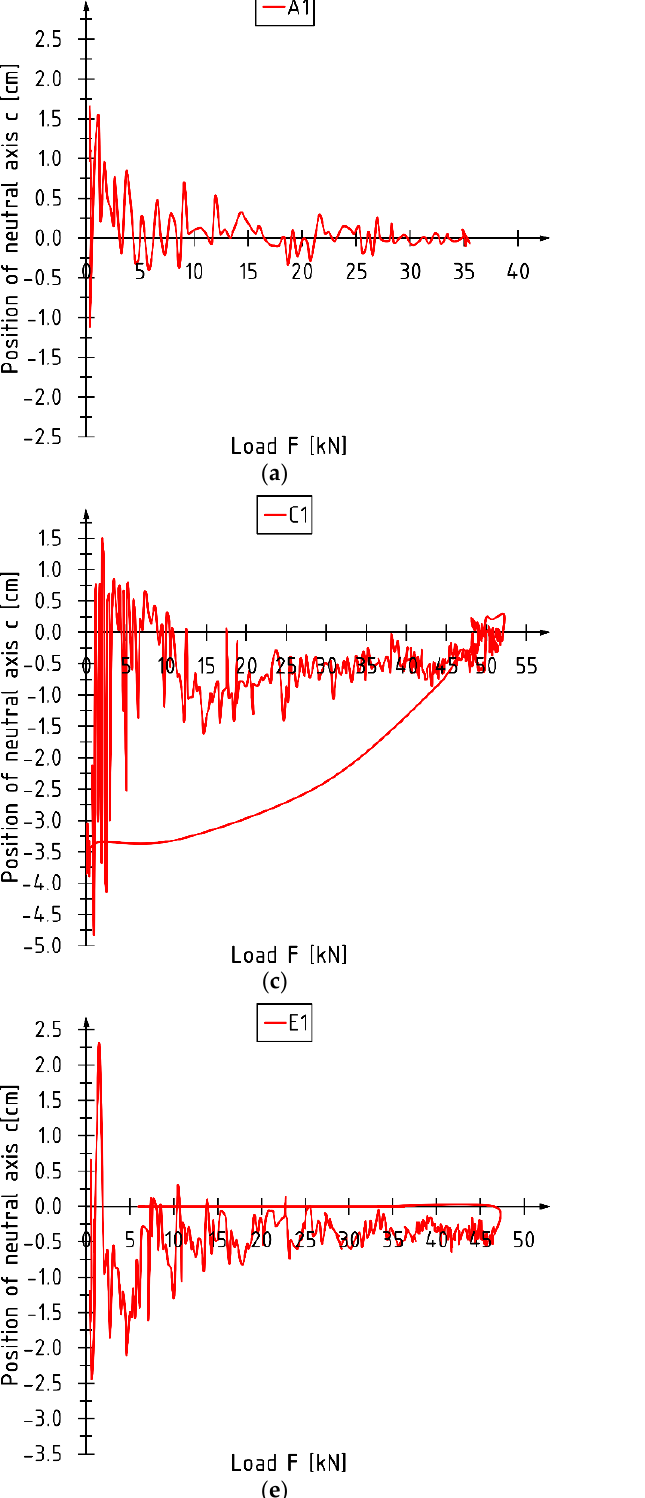
Figure 10. Changes in position of neutral axis for beam: ( a ) A1; ( b ) B1; ( c ) C1; ( d ) D1; ( e ) E1; ( f )